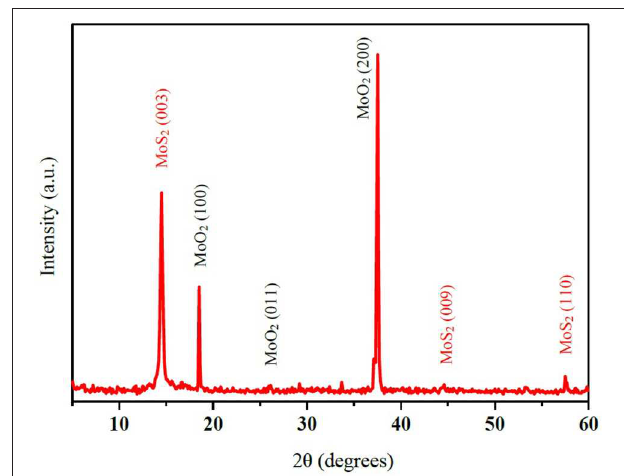
FIGURE 1 | X-ray diffraction pattern of the MoS 2